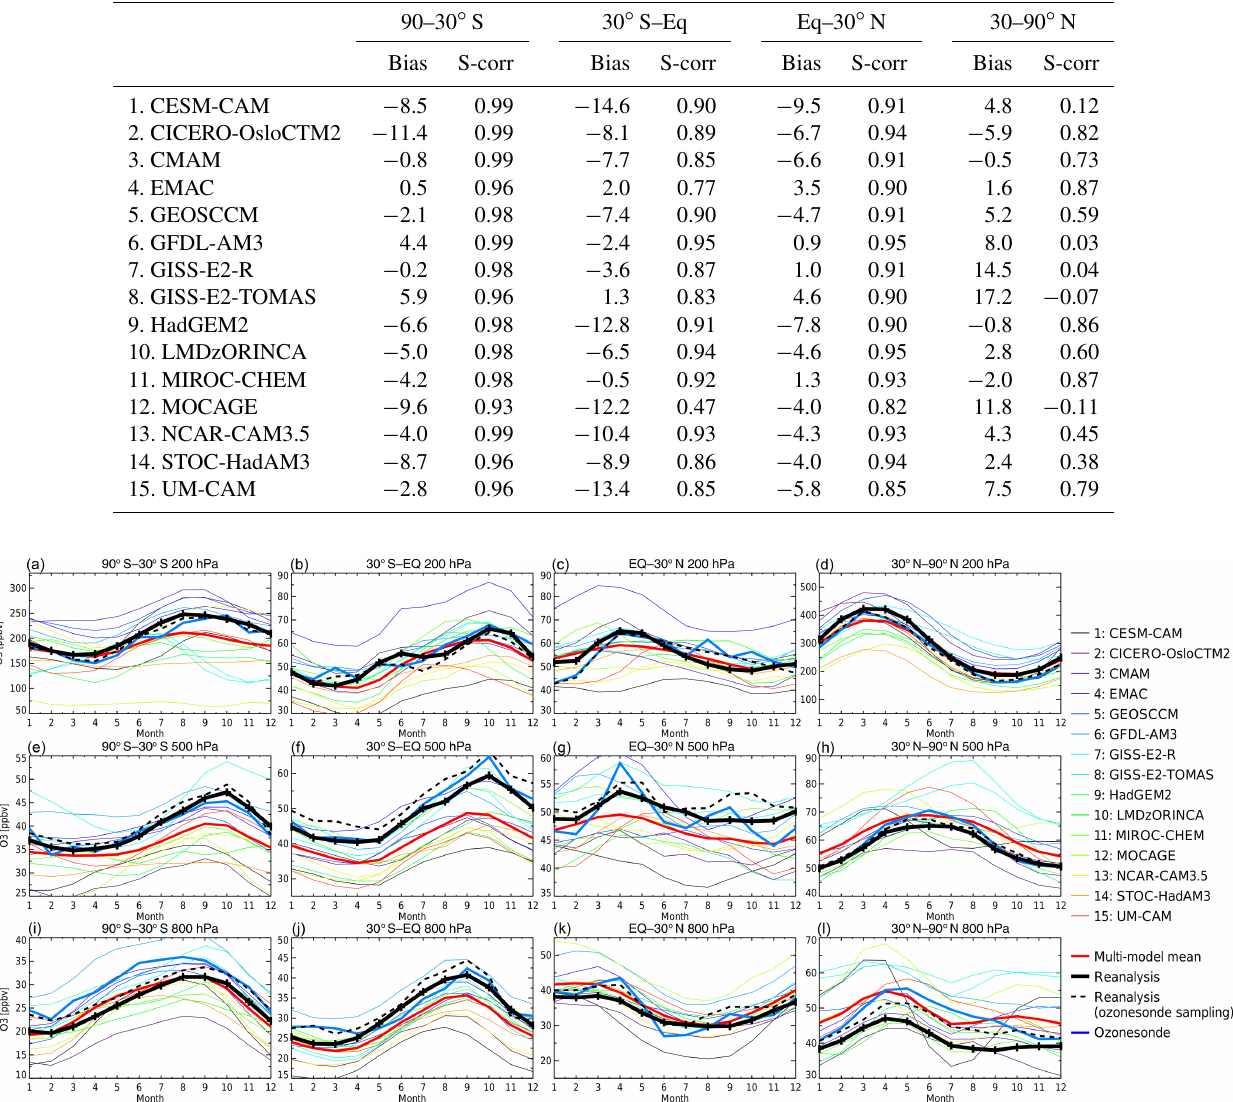
Figure 5. Comparison of seasonal variation of ozone concentration between the reanalysis (black lines), individual ACCMIP models (thin colored lines), ACCMIP ensemble mean (red solid line), and ozonesonde observations (blue solid line) averaged between 90–30 ◦ S (a, e, i) , 30 ◦ S–Eq (b, f, j) , Eq–30 ◦ N (c, g, k) , and 30–90 ◦ N (d, h, l) . From top to bottom, results are shown for concentrations at 200, 500, and 800hPa. Individual model results are shown by colored thin lines. The reanalysis result is shown for the average over all model grid points (black solid line) and over the ozonesonde sampling sites/time (black dashed line). The ACCMIP model results are shown for the average over all model grid